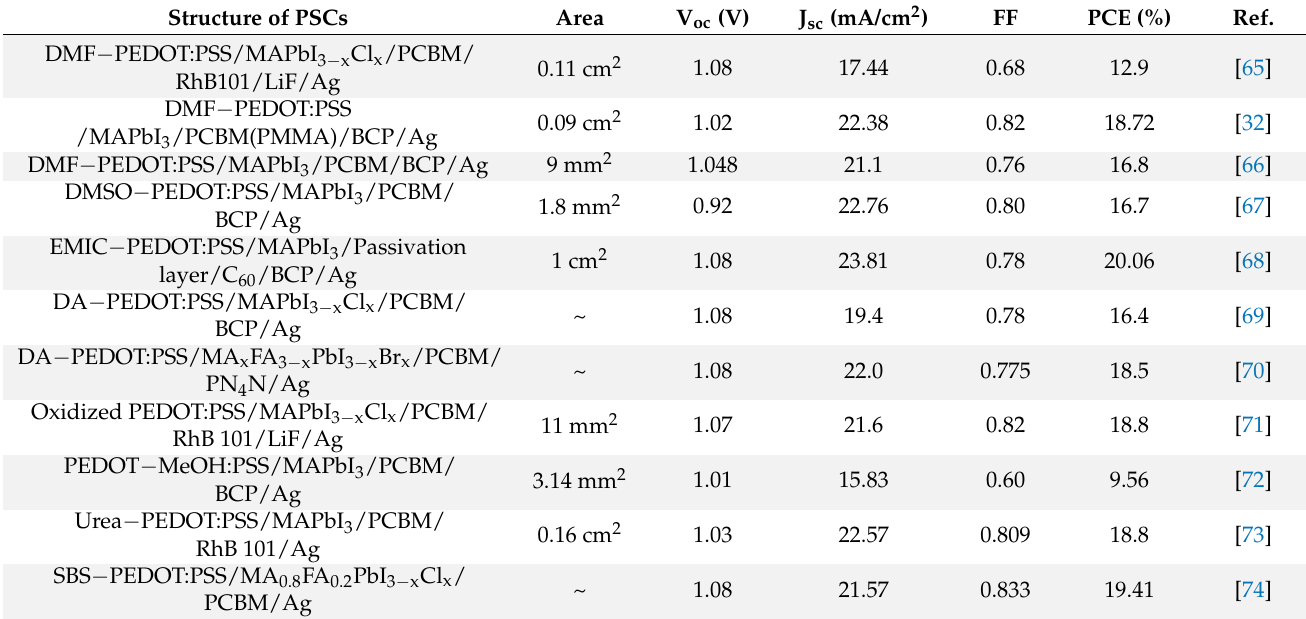
Table 3. Performances of several representative inverted PSCs on the basis of the modified